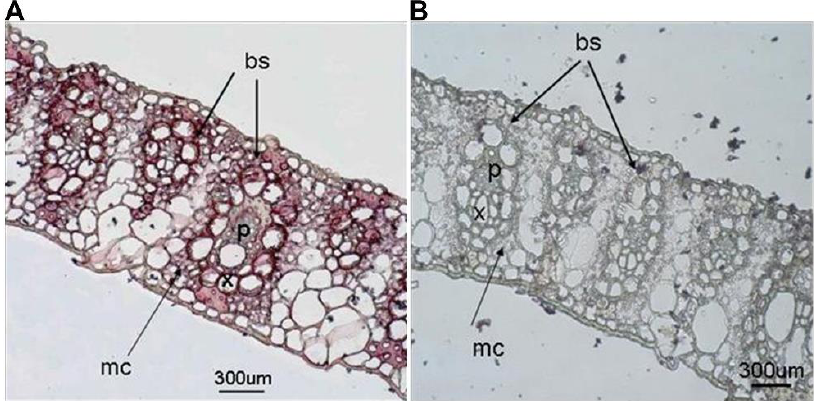
Figure 5. Ubiquitous expression of ScRpb4 transcripts in mature sugarcane leaves. ( A ) Hybridization signal of ScRpb4 mRNA across transversal sections of a mature sugarcane leaf. Accumulation of ScRpb4 transcripts is observed as a purple precipitate. ( B ) Sense probe used as a control. No signal was detected. bs, bundle sheath cells; x, xylem; p, phloem; mc, mesophyll cells. Scale bar = 300 µm.